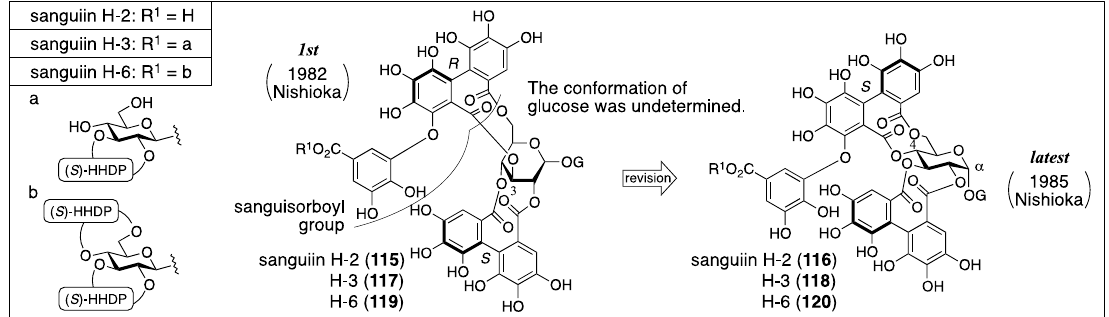
Figure 42. The transformations that led to the latest structures of punicalin and punicalagin.